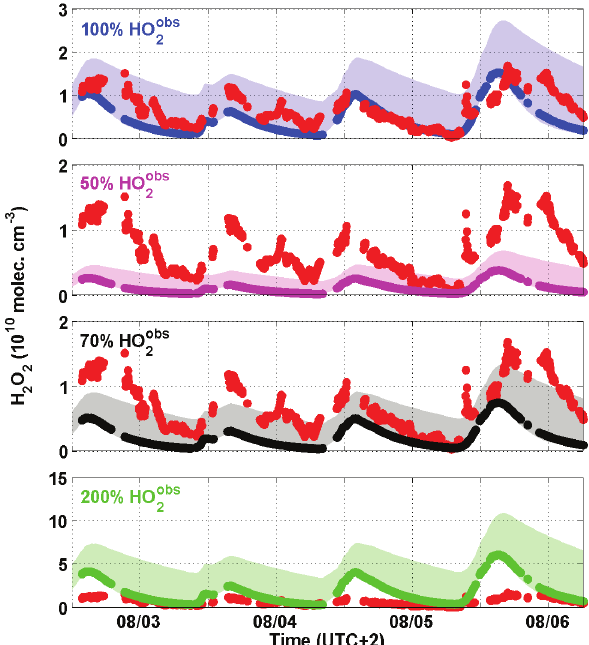
Figure 3. Comparison of measured H 2 O 2 (red dots) with simula- Fig. 3. Comparison of measured H 2 O 2 (red dots) with simulations tions based on assumed deviations of HO 2 measurements by LIF. based on assumed deviations of HO 2 measurements by LIF. Shaded Shaded areas indicate the influence of deposition velocities ranging areas indicate the influence of deposition velocities ranging between between 1 and 5 cms − 1 . 1 and 5 cms − 1 .